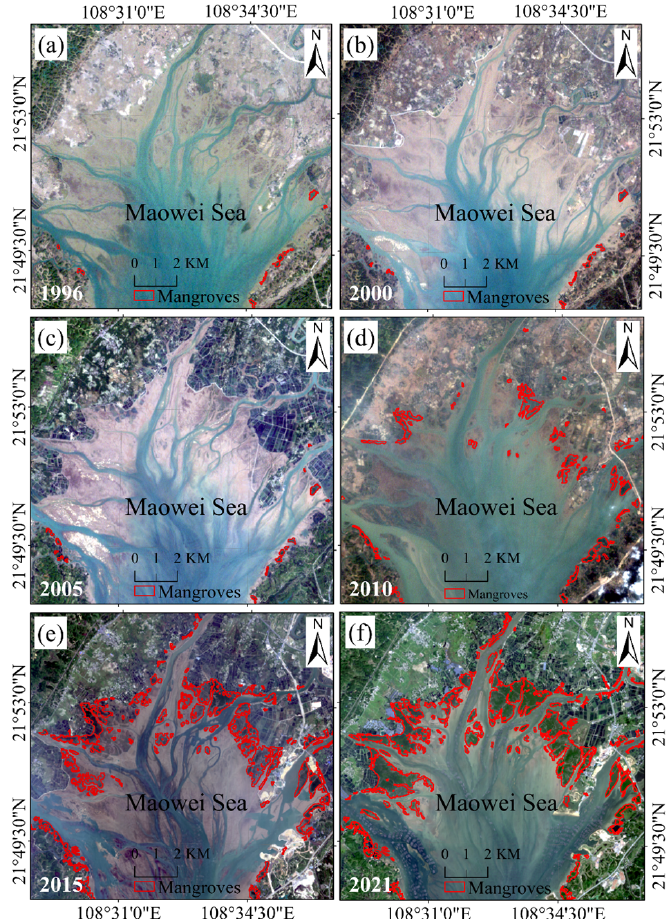
Figure 15. Spatio-temporal distribution of mangroves in Maowei Sea. ( a ) Distribution of mangroves in Maowei Sea in 1996. ( b ) Distribution of mangroves in Maowei Sea in 2000. ( c ) Distribution of mangroves in Maowei Sea in 2005. ( d ) Distribution of mangroves in Maowei Sea in 2010. ( e ) Distribution of mangroves in Maowei Sea in 2015. ( f ) Distribution of mangroves in Maowei Sea in 2021. Table 4. Mangrove area in key study area.